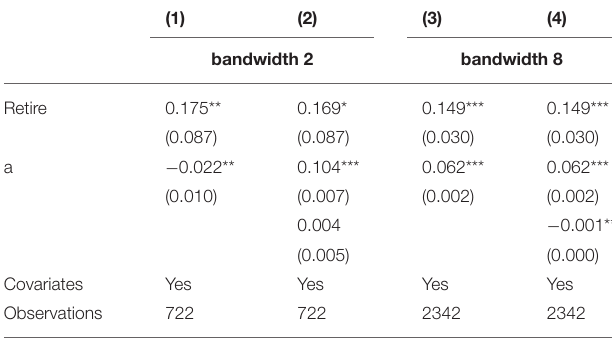
TABLE 6 | FRD estimation results using different bandwidth.